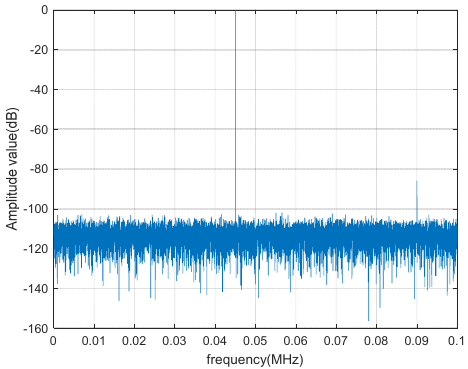
Figure 7. Spectrum of an incoherently sampled ADC after using the proposed method ( N DATA = 16,384, C WIN = 3686.4).